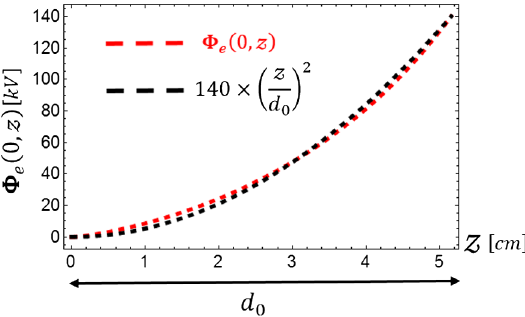
FIG. 3. Numerical solution for the potential equation with linear decrease in the beam envelope to half of its initial value in comparison with a parabola.